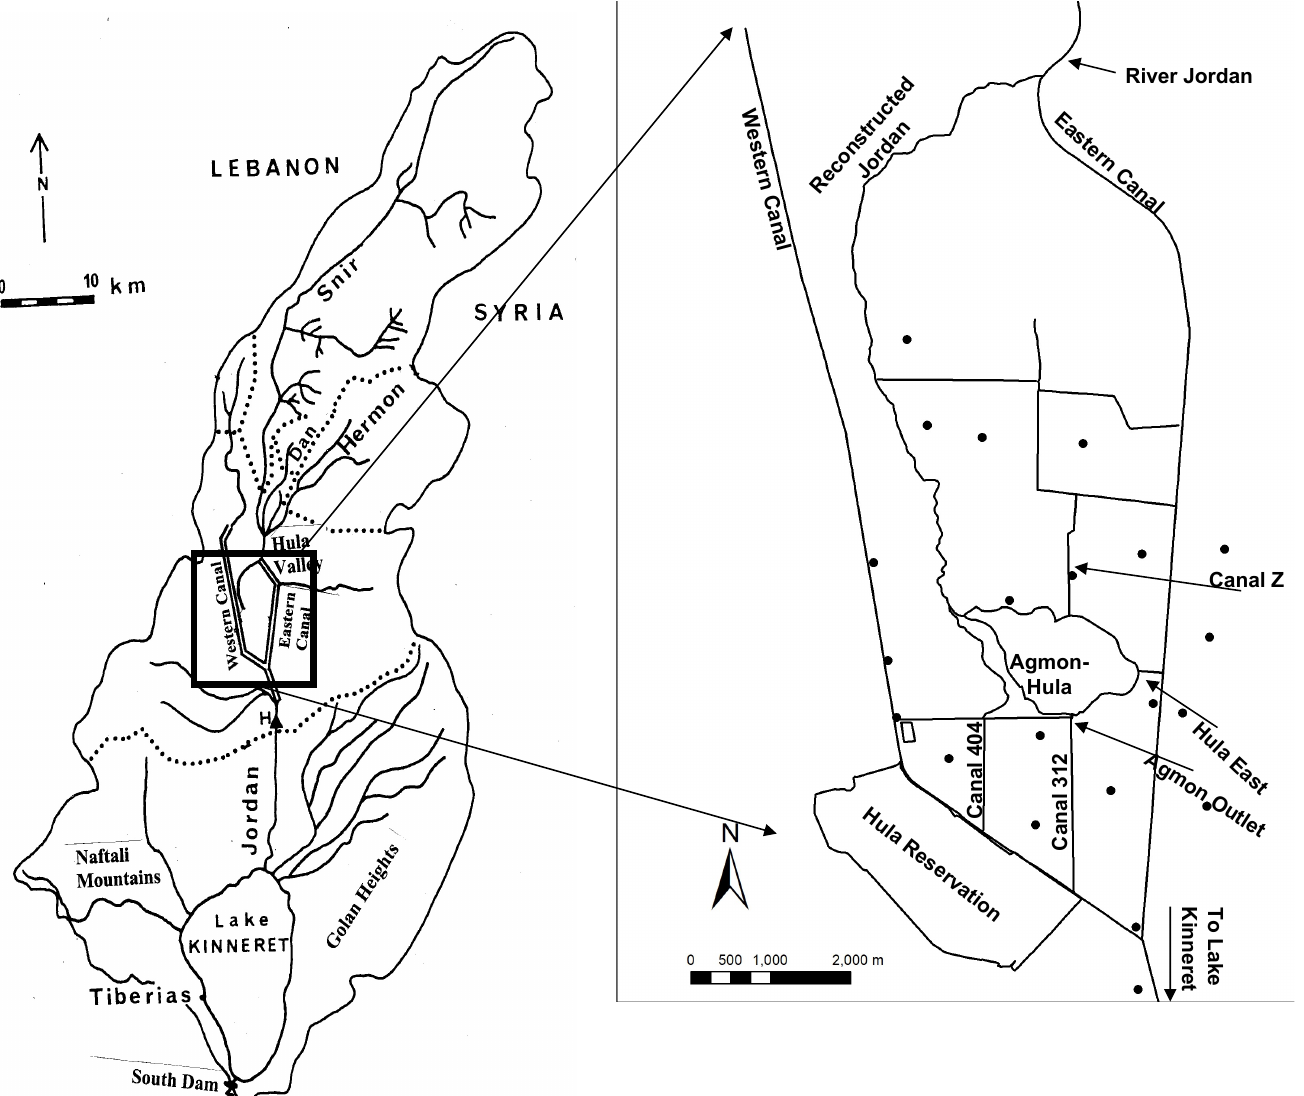
Figure 1. Geographical maps of the Kinneret watershed ( left) and Hula Valley ( right ). Bore-holes (drills for monitoring of GWT depth) (black spots) are